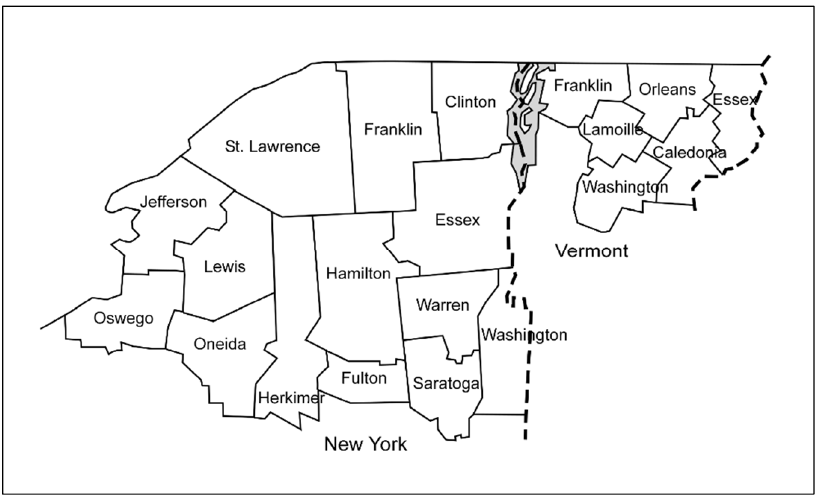
Figure 1. Northern Forest Region of NY and